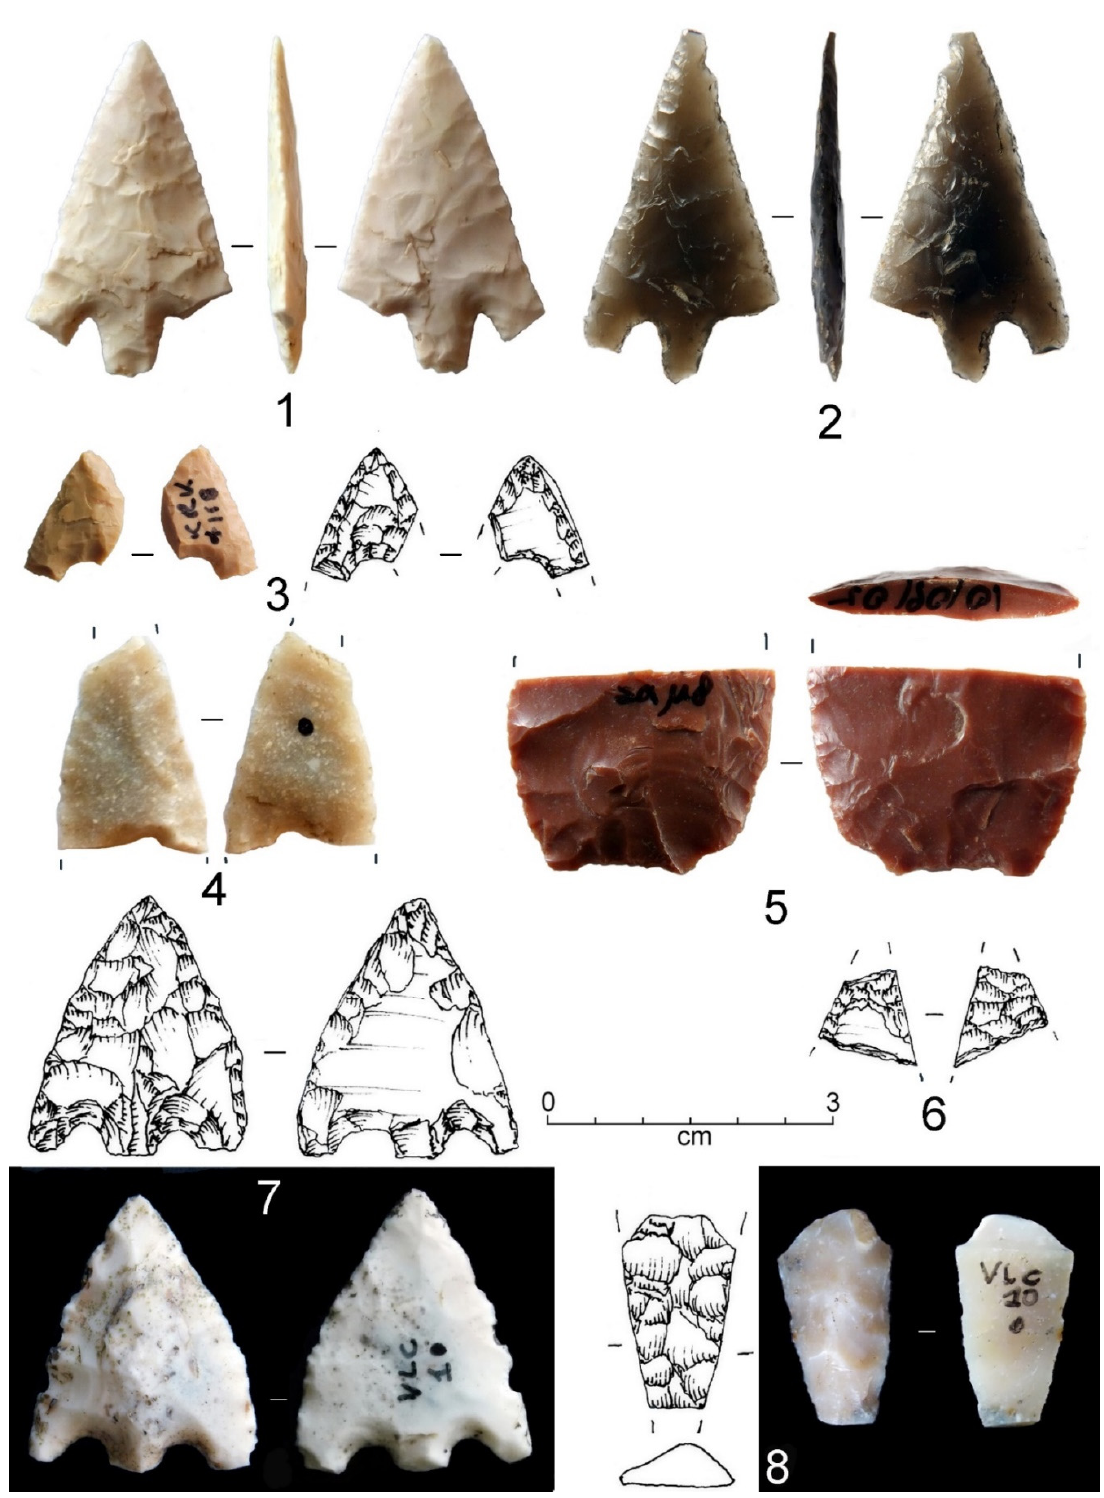
Figure 7. Triangular, barbed-and-tanged arrowheads with flat invasive or covering bifacial retouch from Kirkuri (KRK-28, n. 1), Sam-8 (n. 2), Mirminda Pass (VLC-1, n. 7); hollow-based arrowhead from Kirkuri (KRK-118, n. 3); fragments of arrowheads from Kirkuri (KRK-14, n. 4; KRK-92, n. 6) and the Mirminda Pass (VLC-10, n. 8); proximal fragment of dagger obtained by flat, covering bifacial retouch from Sam-8 (n. 5) (photographs by E. Starnini; drawings by P. Biagi; inking by G. Almerigogna).